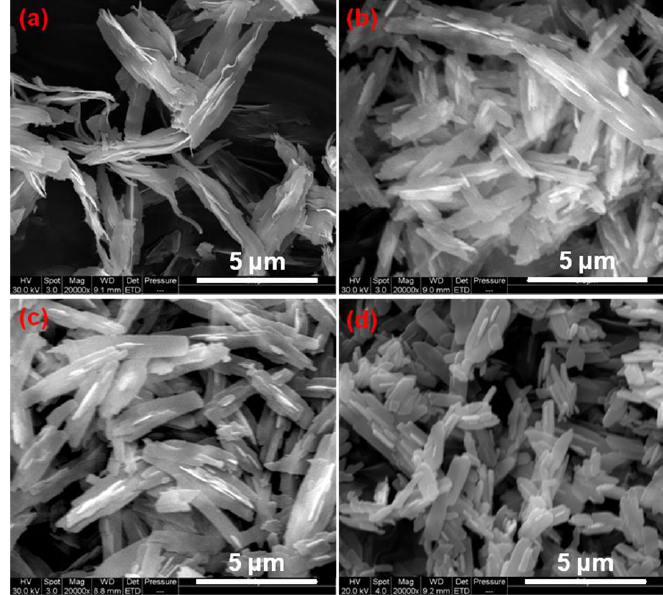
Figure 1. Scanning electron microscope (SEM) images of the as-prepared CuO with different reaction temperatures. ( a )80 °C; (b)120 °C; ( c )160 °C; and, ( d )180 °C.